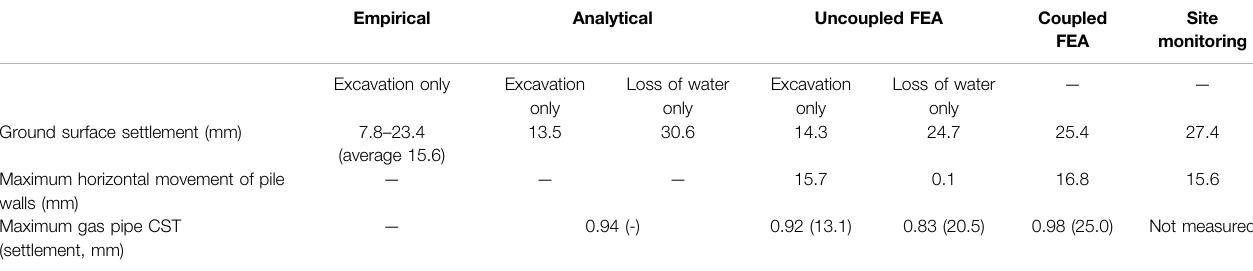
TABLE 4 | Comparison of results from closed-form equations and coupled fi nite element analysis.